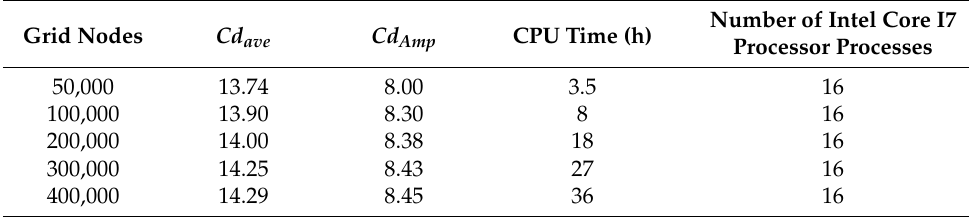
2 m . Table 2. The calculation conditions of the motion parameters. Table 2. The calculation conditions of the motion parameters. Grid Nodes ave Cd Grid Nodes